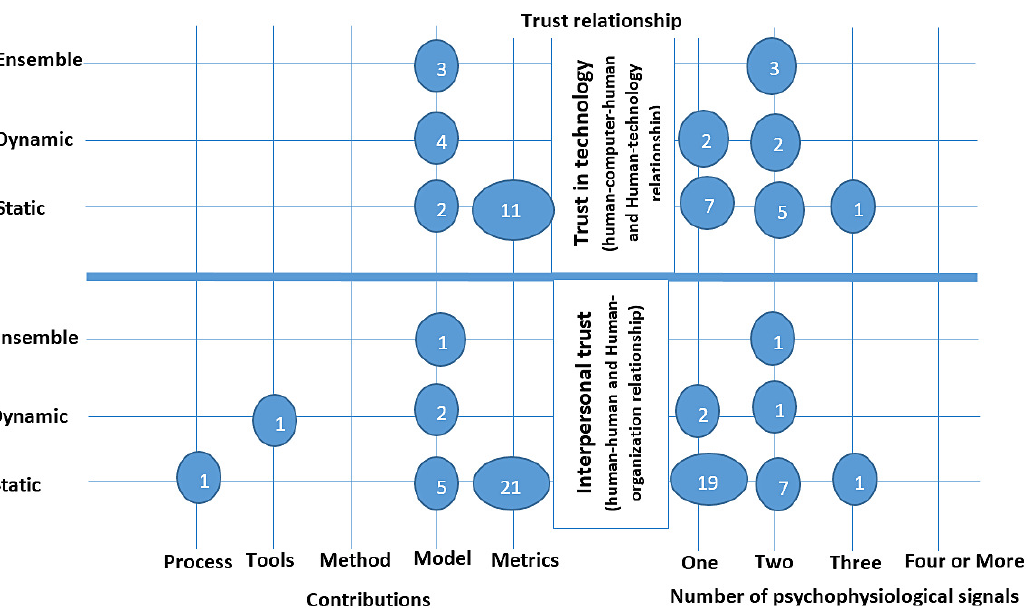
Figure 13. Bubble plot of prior research contributions by context and the number of psychophysiological signals